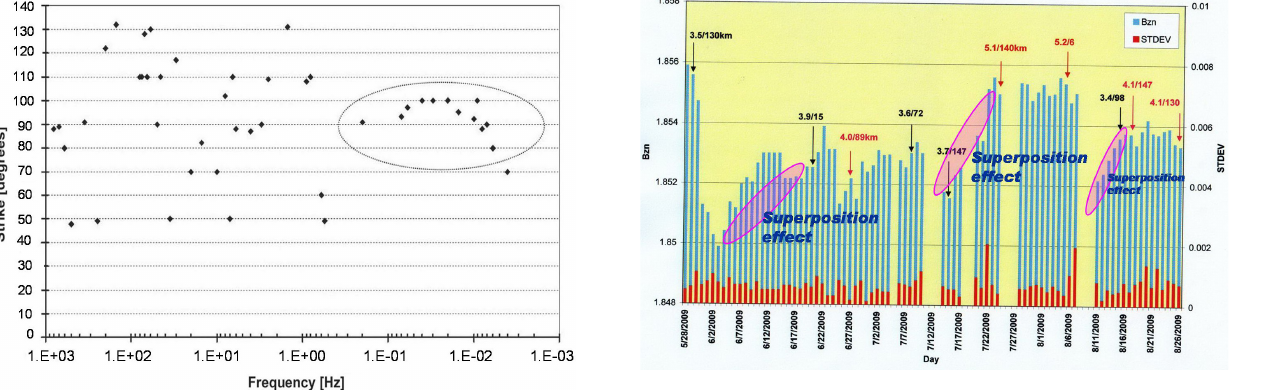
20:18:48 (local time), and was felt in Bucharest and over a large area extended from the epicentral zone towards NE